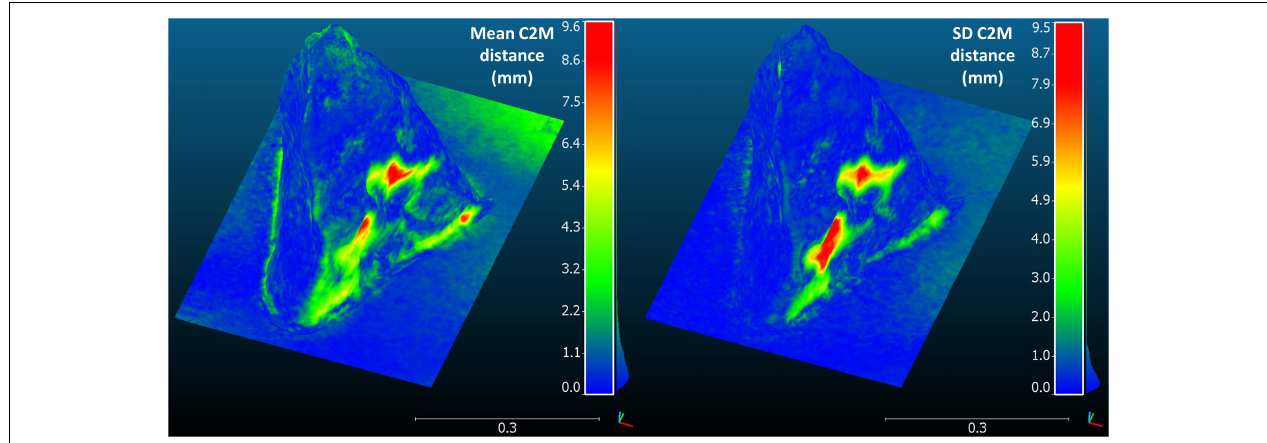
FIGURE 6 | Mean and standard deviation of the absolute cloud-to-mesh distance between the six replicates of the rock model and the in-air reference model. C2M, cloud-to-mesh; SD, standard deviation.